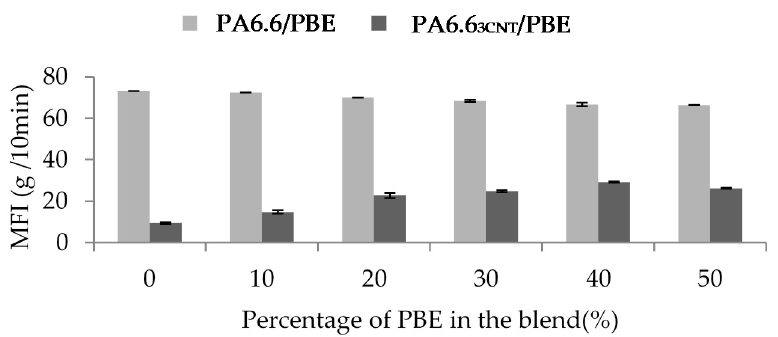
Figure 4. Influence of the percentage of PBE and the presence of CNT on the PA6.6/PBE blends viscosity at 270 °C, 2.16 kg.